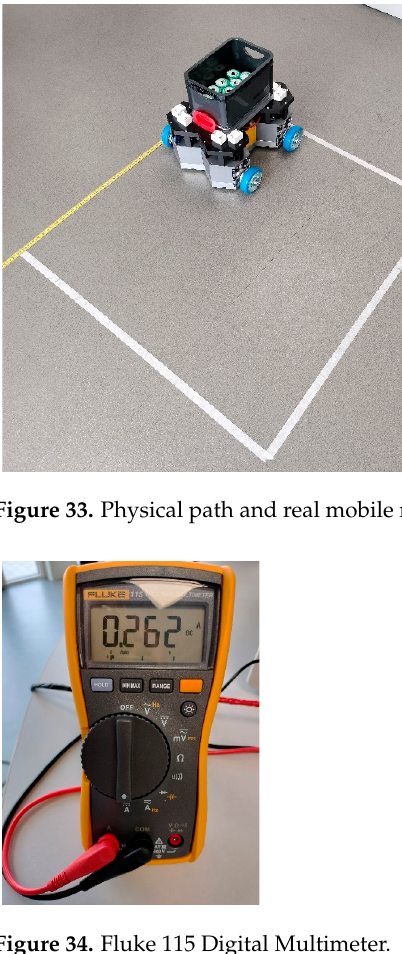
( b ) Figure 35. Current variation measured using the functional model for moving on the rede fi ned path. ( a ) Wheel 1 (similar to wheel 3). ( b ) Wheel 2 (similar to wheel 4). Experimental measurements with the Fluke 115 multimeter were performed by con- necting it in series with the drive motor. A digital chronometer (similar to the app on a smartphone) having the Lap function was used to measure the time. When the Lap bu tt on is pressed, the intermediate times are recorded, which in this application are the current measurement times. It is activated only while the chronometer measures the time between start and fi nish. The measurements of current and time were performed by simultaneously pressing the Hold bu tt on of the mul- timeter and the Lap bu tt on of the chronometer, while the robot is moving along the path. It is important to specify that these measurements were performed during the linear movement of the robot where the current fl uctuations are small and not during the turn- ing. The values obtained after the measurements were compared with those measured using the ACS712-05 sensor. They are graphically represented in Figure 35a,b. On the graphs, one can see the position of the measurement times t 1 , t 2 and t 3 , t 4 and t 1 ’, t 2 ’, t 3 ’ and t 4 ’, respectively.